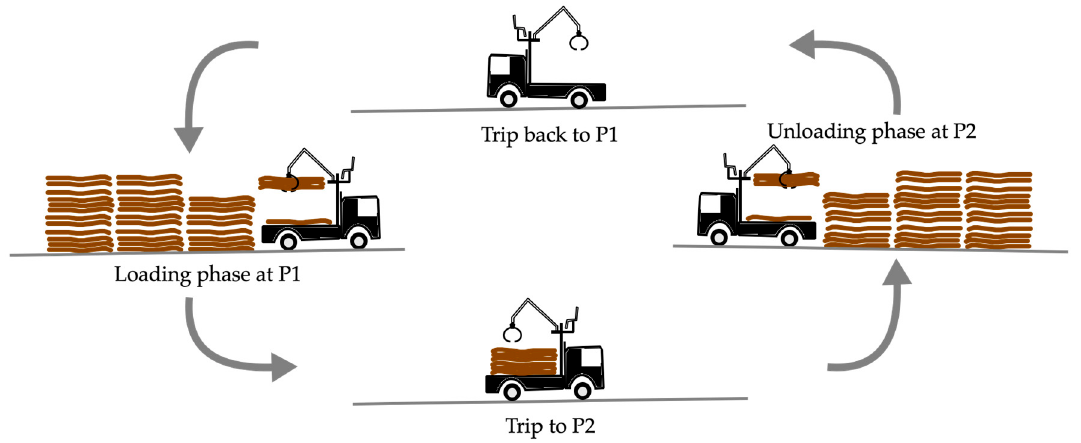
Figure 2. Representation of the cycle of each transport unit (TU).